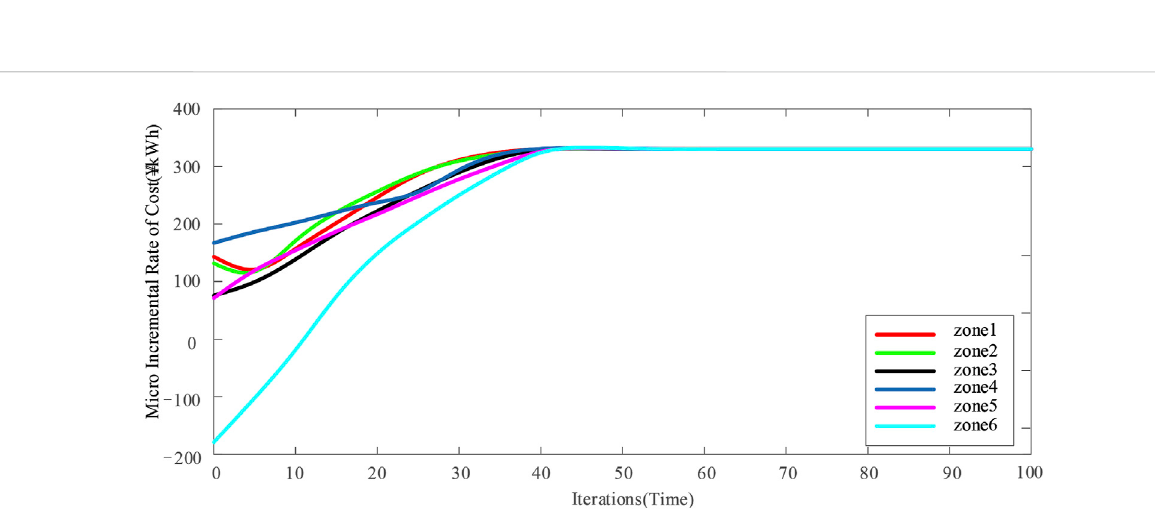
FIGURE 6 Consistent convergence process of the micro-increase rate of cost at